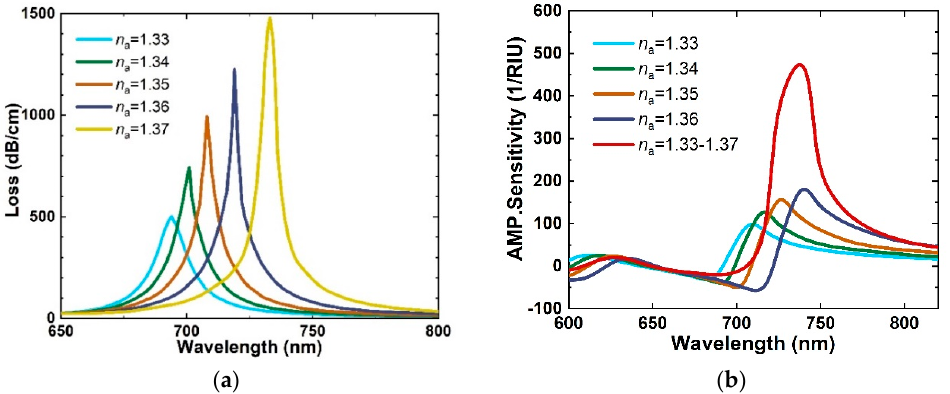
Figure 5. ( a ) Response curve of confinement loss as a function of wavelength for refractive index from 1.33 to 1.37, and ( b ) Amplitude sensitivity with varied refractive index.